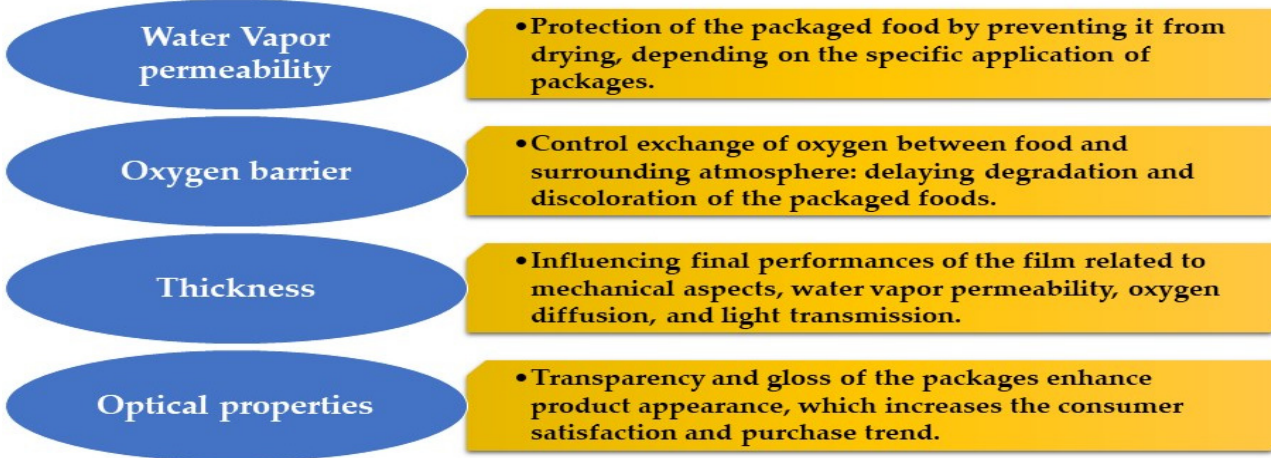
Figure 2. Schematic representation of the complete cycle of marine biopolymers—from production through to the biode- grading of the environment.